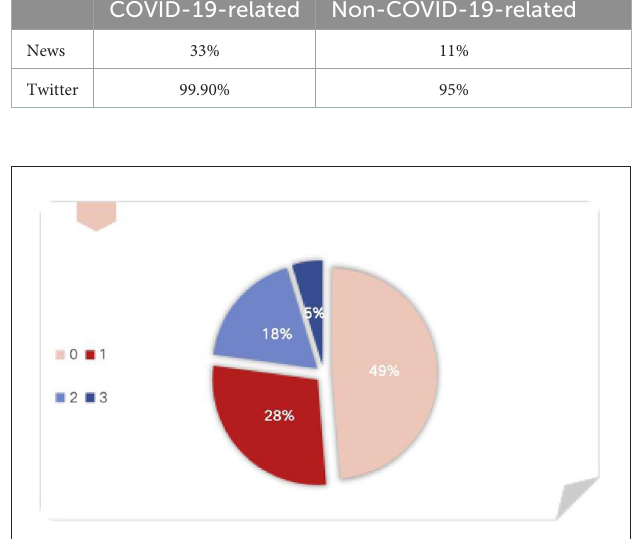
FIGURE1 Preprint frame adoption score in the news media.